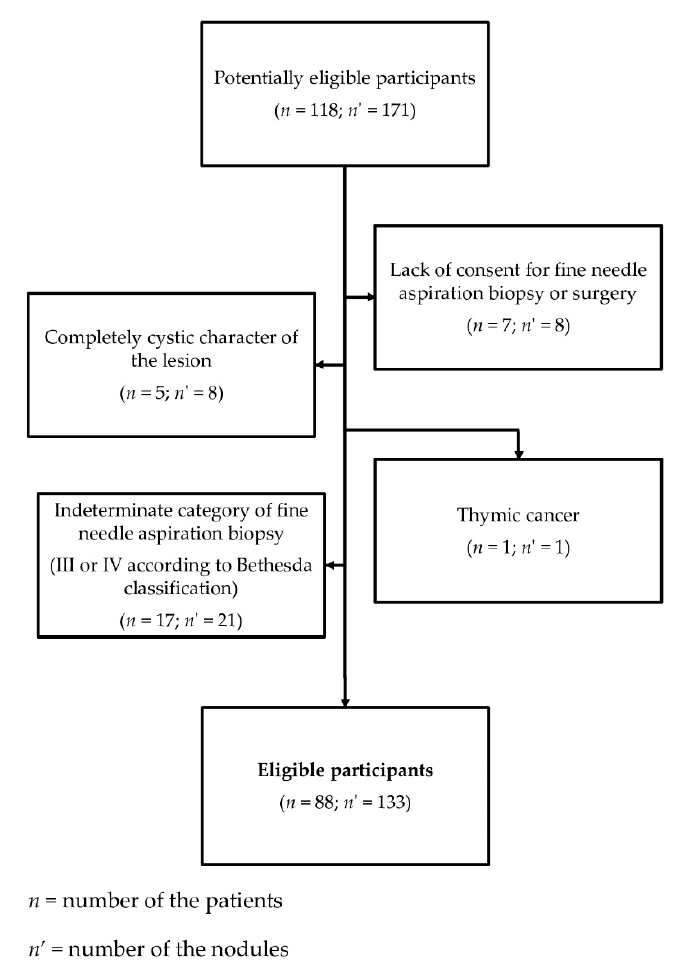
Figure 1. Diagram presenting the process of recruitment of the patients for the